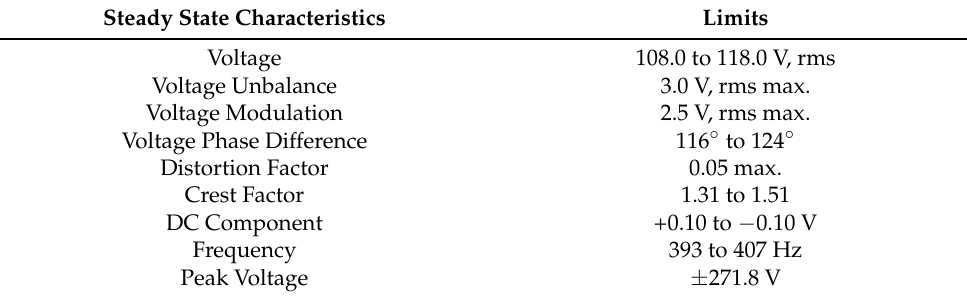
Table 1. Operation Characteristics of 400 Hz AC [10].